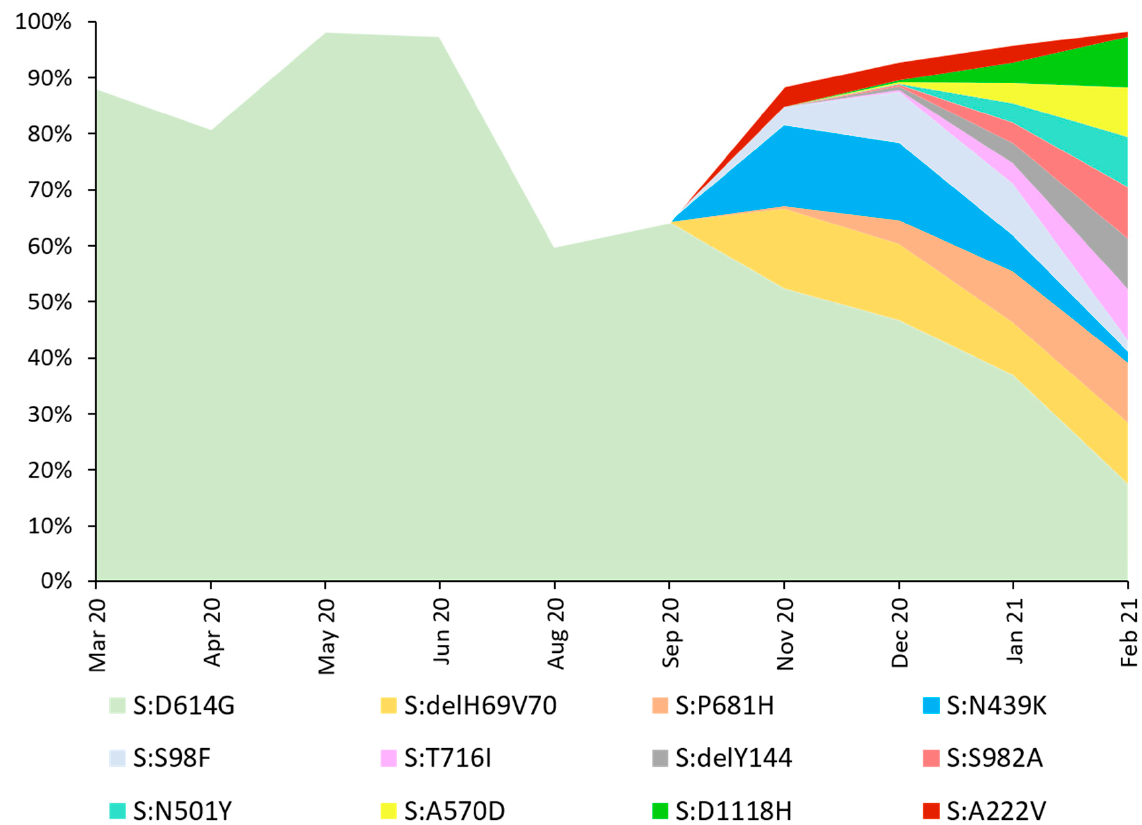
Figure 5. Distribution of SARS-CoV-2 spike mutation in Poland over time. Contribution of individual mutations of the spike protein genetic diversity between March 2020 and February 2021 identified in SARS-Cov-2 strains. No data on the sequences collected in July and October were available. Mutations found in more than 5% of the total analyzed isolates are presented.